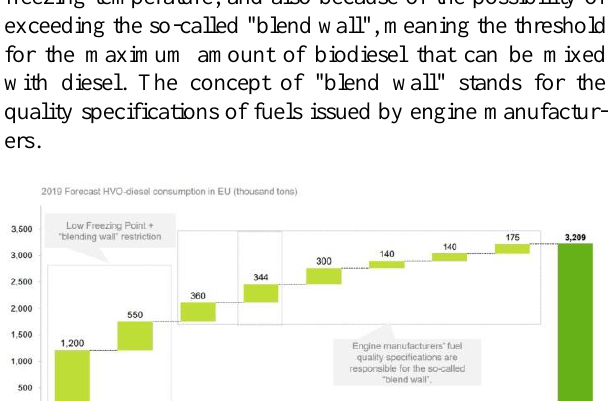
Table 3. Comparison of properties of classic biodiesel and Green Diesel fuel (HVO) [10] Biodiesel Fig. 6. Forecast of HVO fuel consumption in European countries [11] It is forecasted that in 2019, the consumption of HVO fuel in European countries will reach a total of 3,209,000 Mg, with Sweden, Finland, France, Norway and Spain being the largest consumers of this fuel (Fig.